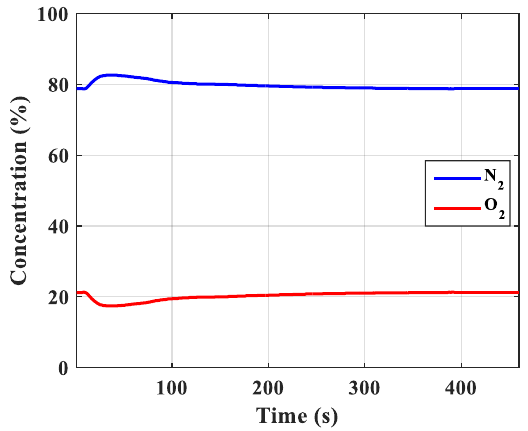
Figure 15. Concentration of gas N 2 at the output of a single fixed bed (see Figure 2).